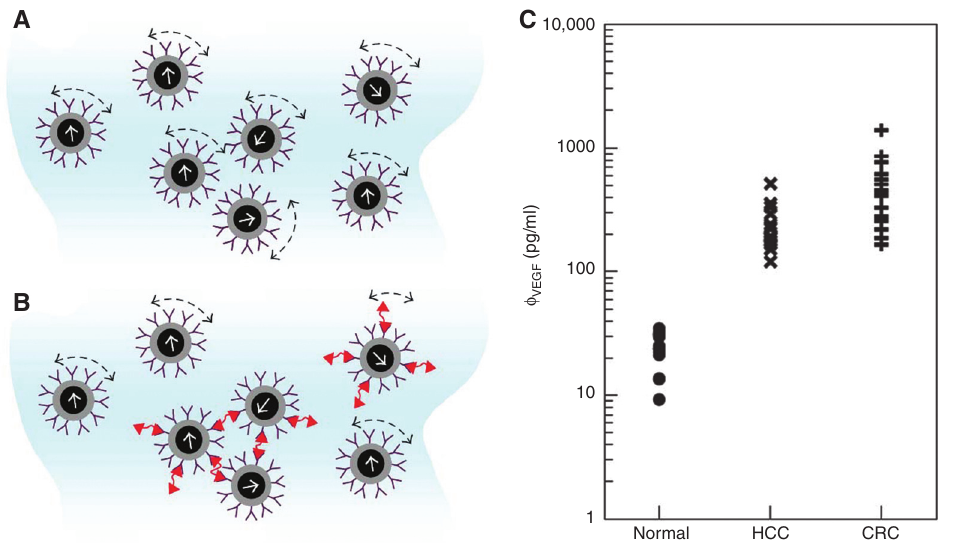
Figure 9 In vitro assay of vascular endothelial growth factor (VEGF) using immunomagnetic reduction (IMR). (A) Under external multiple ac magnetic fields, magnetic nanoparticles oscillate with the multiple ac magnetic fields via magnetic interaction. Thus, the reagent under external multiple ac magnetic fields shows a magnetic property, called mixed-frequency ac magnetic susceptibility. (B) Via the antibod- ies on the outmost shell, magnetic nanoparticles associate with magnetically label targets. With the association, magnetic nanoparticles become larger or clustered. The response of these larger magnetic nanoparticles to external multiple ac magnetic fields becomes much less than that of originally individual magnetic nanoparticles. (C) Detected VEGF concentrations in serum using SQUID-based IMR for normal people and patients with hepatocellular carcinoma (HCH) or colorectal cancer (CRC). (Reproduced with permission from Ref. [146], Copyright Hindawi Publishing Corporation,